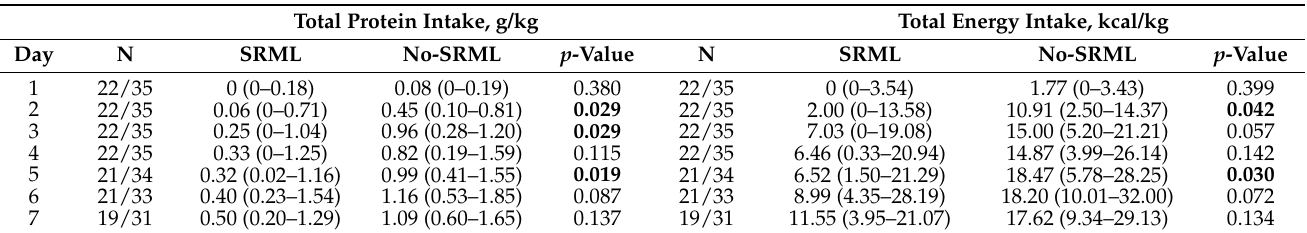
Table 3. Daily postoperative protein and energy intake per kilogram bodyweight compared between the presence of clinically relevant